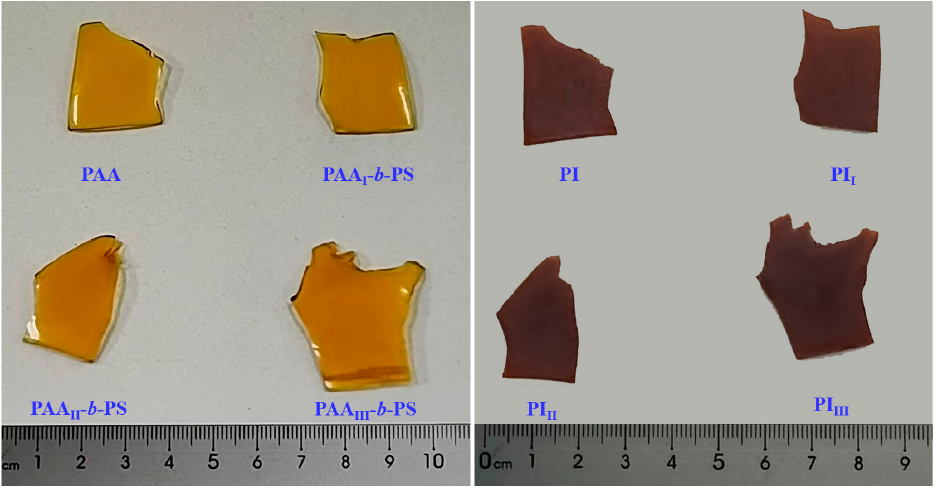
Figure 4. Appearance photographs of the films: left , PAA series films; right , PI films from thermal- treated PAA series